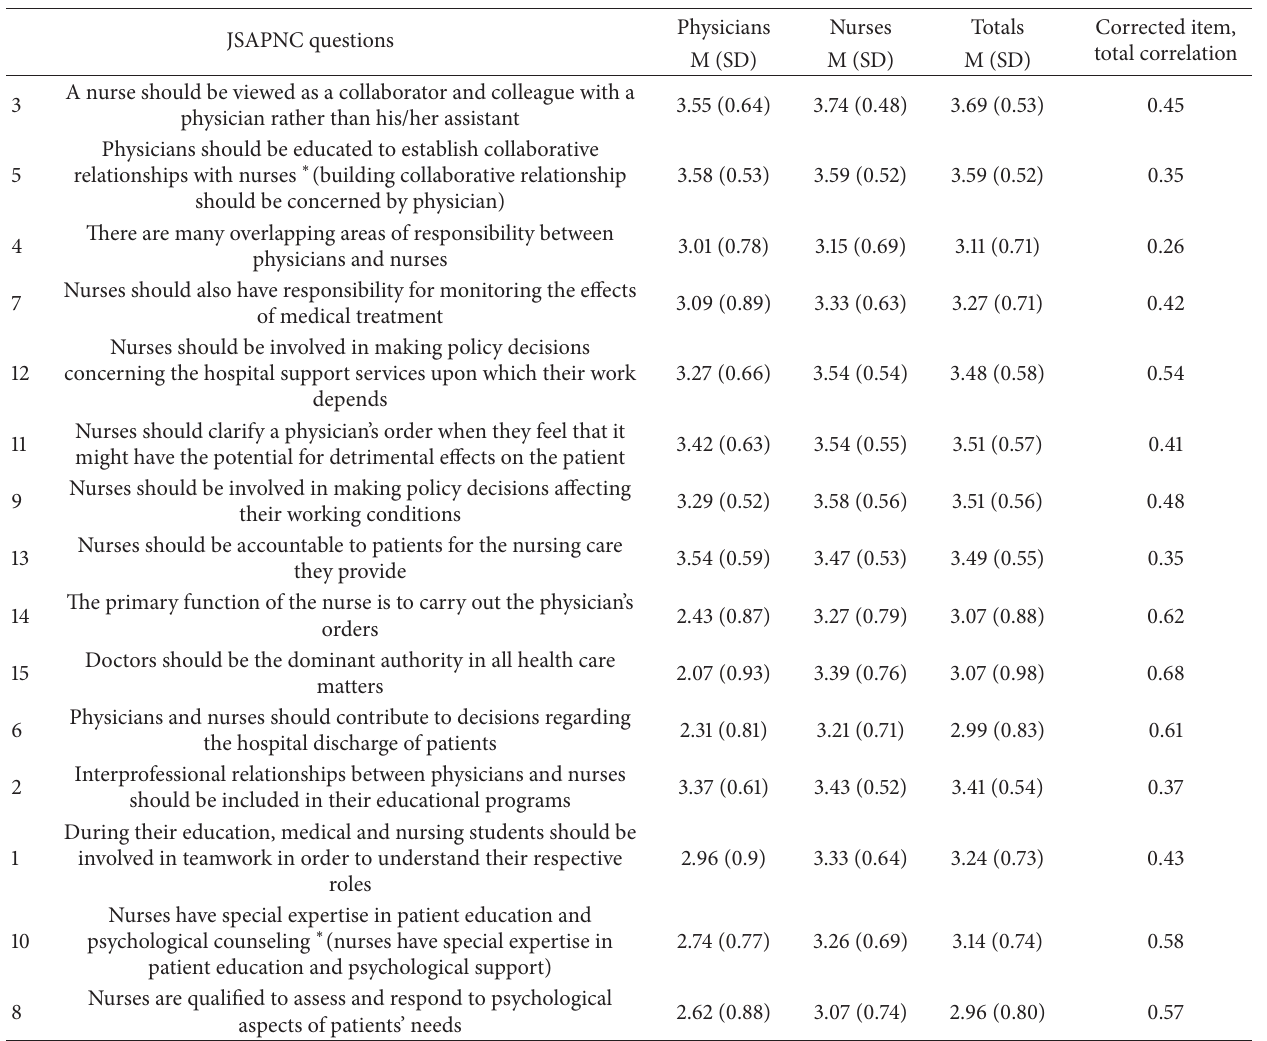
Table 3: JSAPNC individual item mean